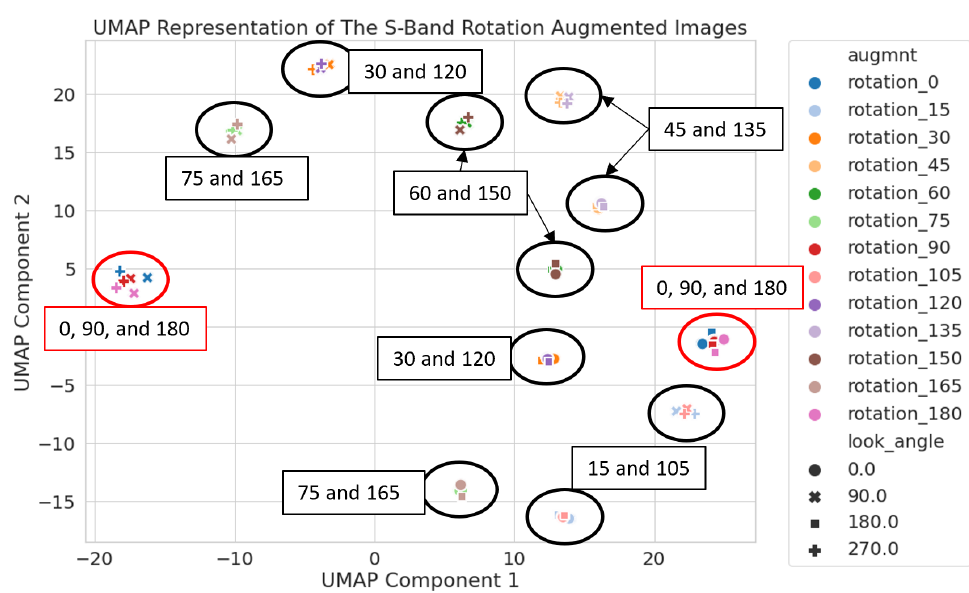
Figure 3. S-band latent space with labels for the rotation augmentation angle of each cluster. These labels help to show that clusters are forming based on the difference of the rotation angle from 0 ◦ or 90 ◦ , revealing inadvertent clustering based on the rotation of a square